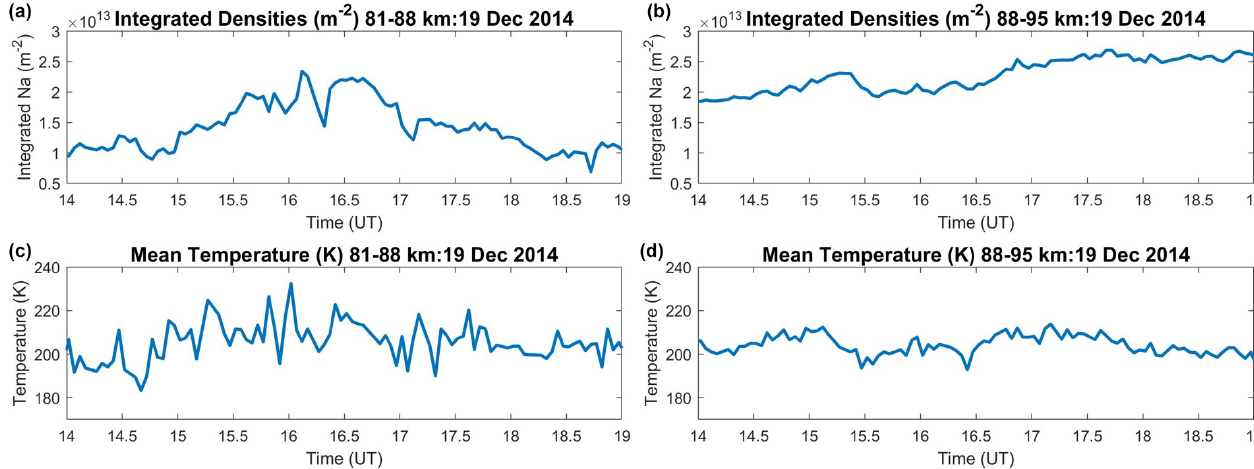
Figure 13. Panels (a) and (b) are integrated sodium densities from 81 to 88km and 88 to 95km, respectively. Panels (c) and (d) are averaged temperatures from 81 to 88km and 88 to 95km,